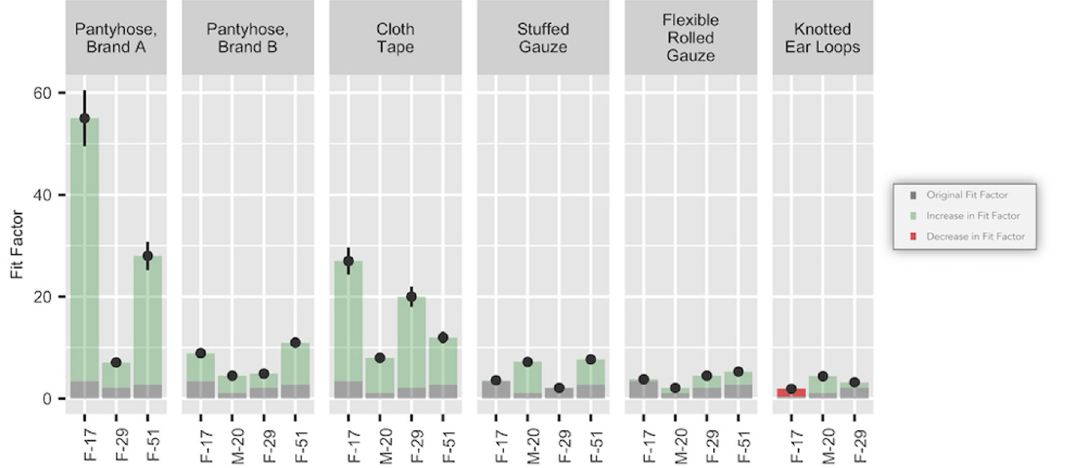
Fig 2. Fit hacks applied to KN95 masks. Gray portions of the bars indicate the performance without the application of a fit hack. Green portions of the bars indicate the amount of improvement. The red portion of the bar indicates the amount of decrease in